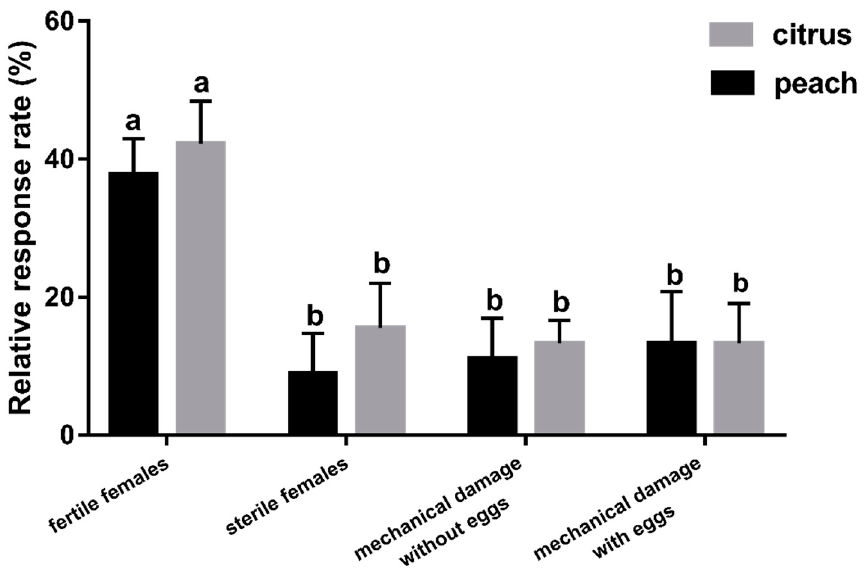
Figure 5. Behavioural responses of F. arisanus females to two fruits exposed to fertile and sterile B. dorsalis females, mechanically damaged fruits without eggs and mechanically damaged fruits with egg embedding. The data are expressed as mean ± SD. Different lowercase letters denote statistical differences by Tukey’s multiple range test ( p < 0.05). N = 9.